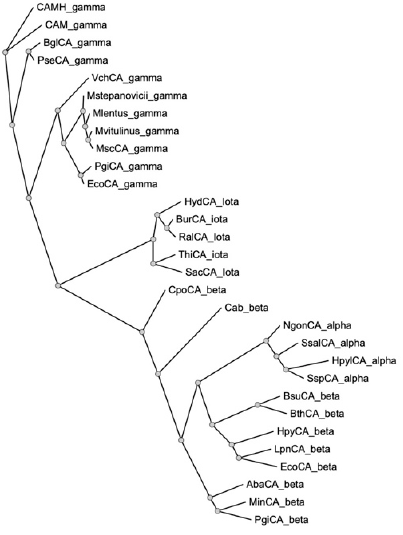
Figure 2. The phylogenetic tree was constructed using the software PhyML 3.0 and using α -, β -, γ -, and 𝜄 -CAs identified in different bacterial species. Legend: CAMH_gamma, Methanosarcina thermophila TM-1, ACQ57353.1; CAM_gamma, Methanosarcina thermophila , WP_052721819.1; BglCA_gamma, Burkholderia gladioli , WP_013697304.1; PseCA_gamma, Pseudomonas sp., WP_010168409.1; VchCA_gamma, Vibrio cholerae , WP_000095101.1; Mstepanovicii_gamma, Mam- maliicoccus stepanovicii , WP_095087344.1; Mlentus_gamma, Mammaliicoccus lentus ,